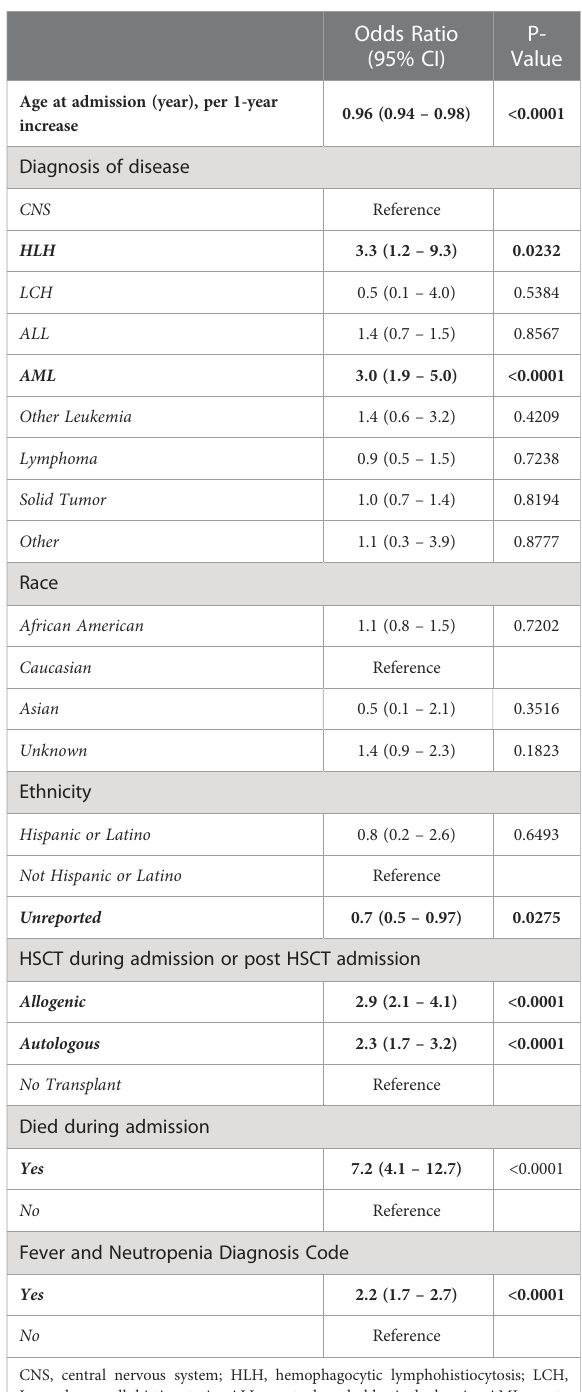
TABLE 4 Multivariable analysis of risk factors associated with positive blood cultures during admission